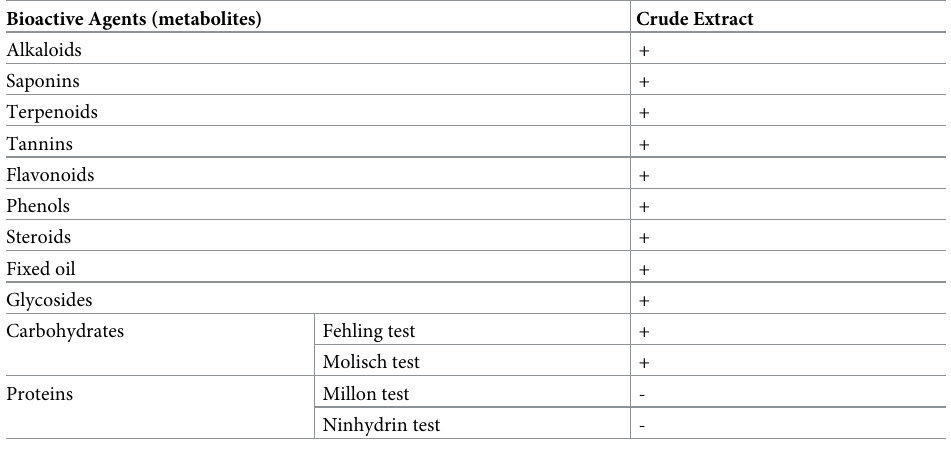
Table 1. Phytochemical analysis of crude extract of I . albicans